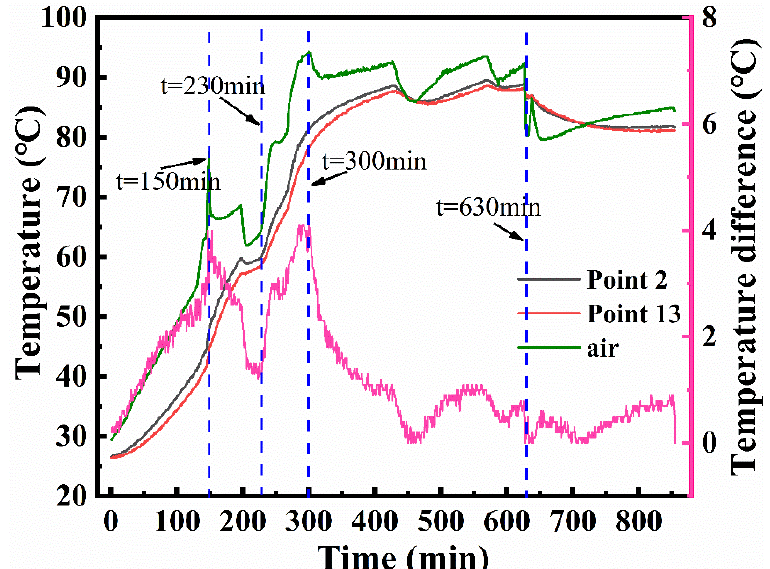
Figure 5. The maximum temperature difference.